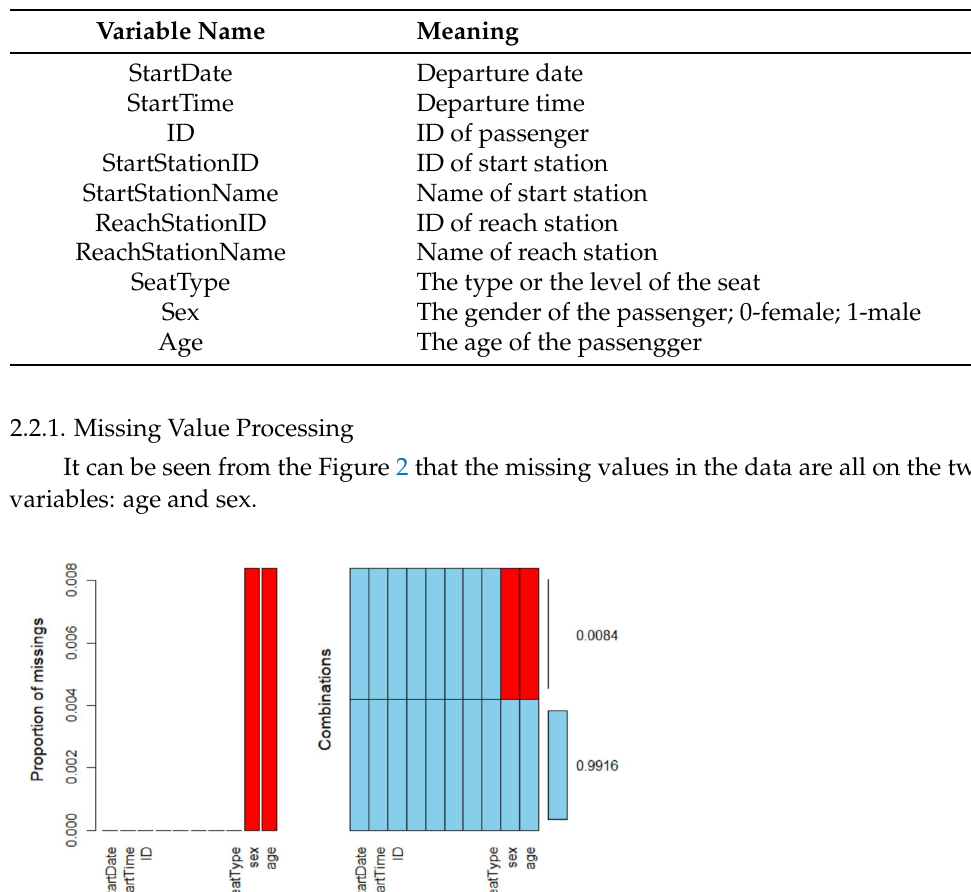
Table 2. Variable description. The dataset include 10 variables.